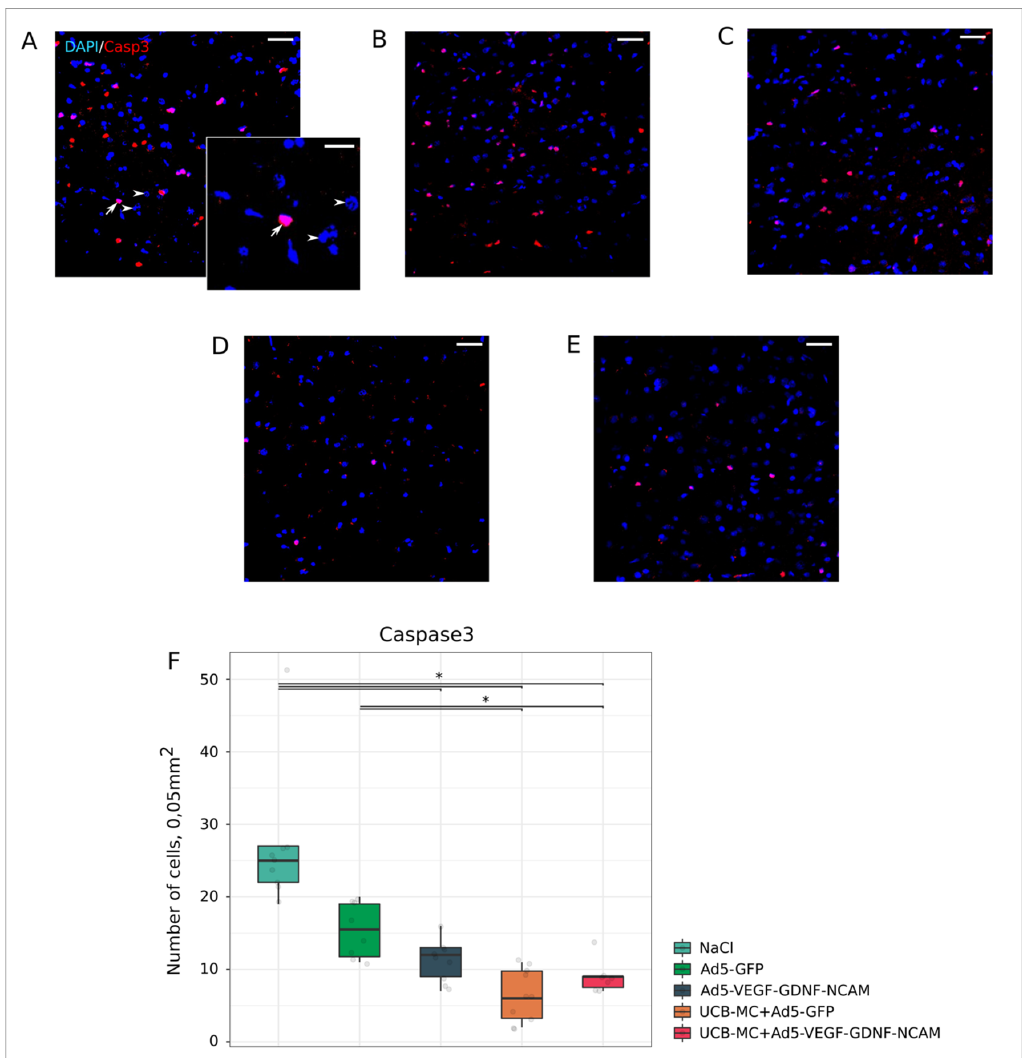
Figure 4. Count of Caspase3-positive cells in the rat brain cortex, 21 days after the middle cerebral artery occlusion. Immunofluorescent staining with antibody to Caspase3 in control NaCl ( A ) and Ad5-GFP ( B ), and therapeutic UCB-MC + Ad5-GFP ( C ), Ad5-VEGF-GDNF-NCAM ( D ) and UCB-MC + Ad5-VEGF-GDNF-NCAM ( E ) groups. Arrow indicates nuclear localization of Caspase3 (red glow) in brain cells. Arrowheads point to cell nuclei visualized using DAPI (blue glow). Scale bar in ( A – E ) = 50 µ m; scale bar in the insert = 20 µ m. ( F )—comparative analysis of Caspase3-positive cells number in experimental groups; *— p <